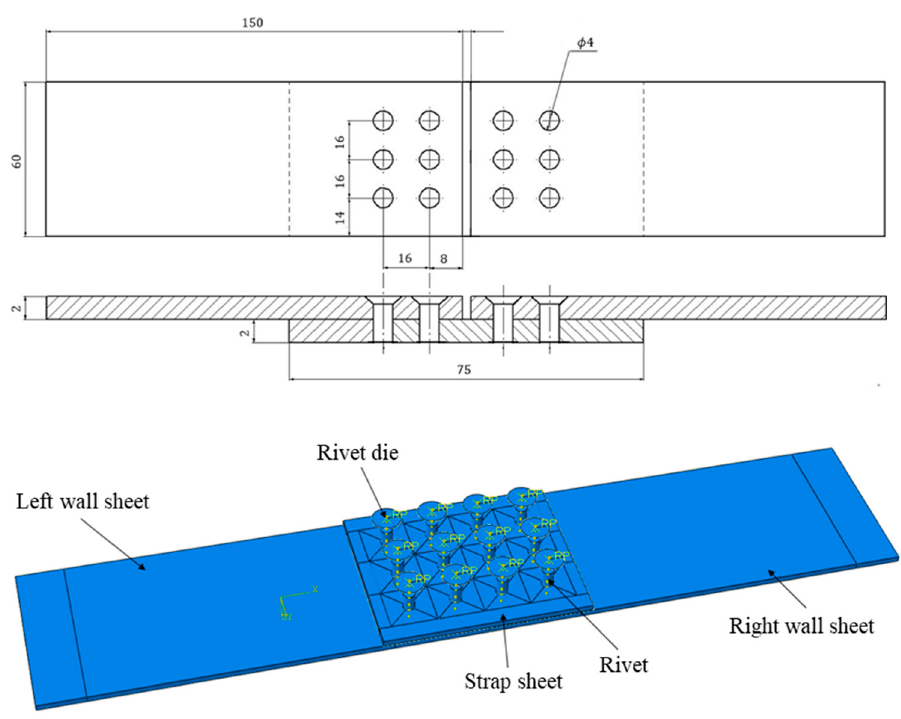
Figure 3. Schematic diagram of the dimensions and finite element models of the single-strap sheet connection joint.